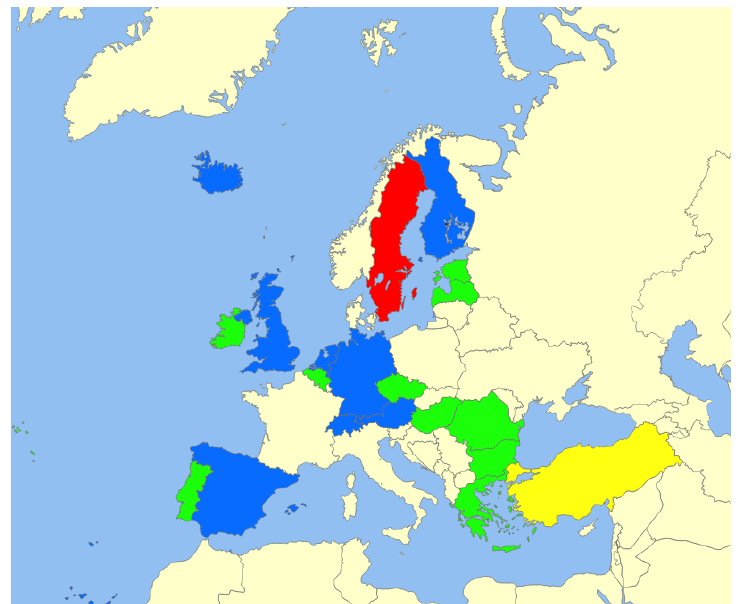
Figure 3. Four clusters of the press based on emancipative values and the journalists’ perception of their role as promoting tolerance and cultural diversity.